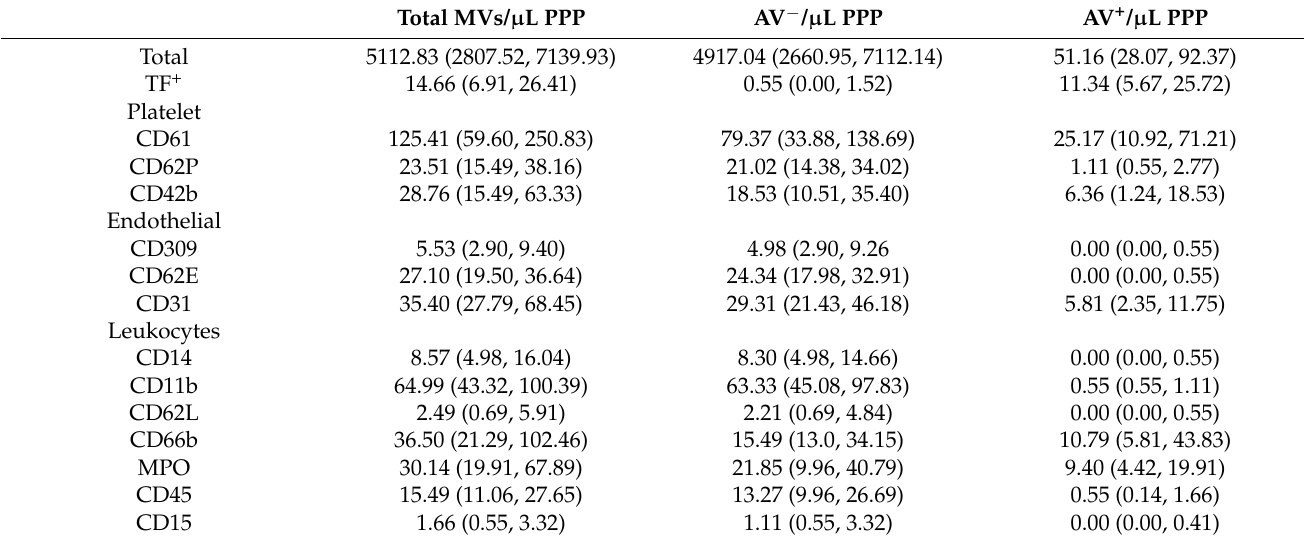
Table 2. Total levels of MVs and subgroups according to cell type in STEMI patients (n = 32) at the time of PCI. Data are presented as medians (25th and 75th